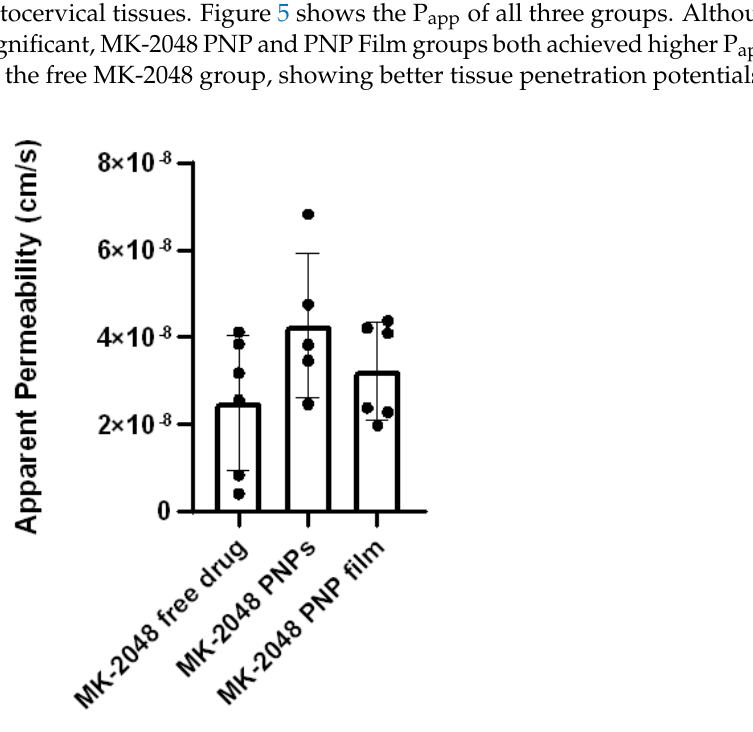
Figure 4. Apparent permeability (P app ) in the transporter overexpressed cell lines. ( a ) MDCKII BCRP cell line (N = 3); ( b ) MDCKII MDR1(P − gp) cell line (N = 6). Results are reported as Mean ± SD.